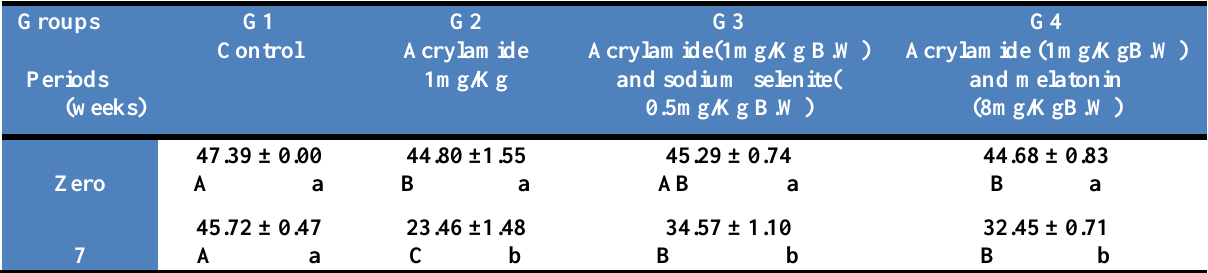
Table, 4: Effect of sodium selenite and melatonin on serum high density lipoprotein (HDL-C) concentration (mg/dl) in acrylamide treated rats.